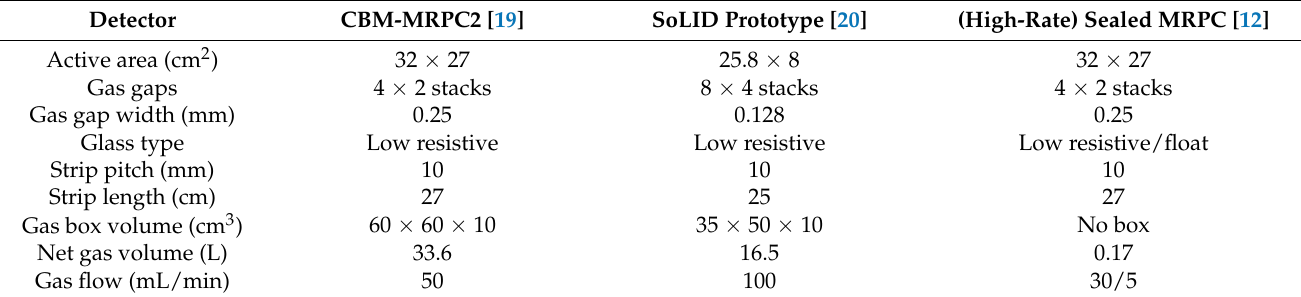
Figure 3. The current response of a SoLID prototype in full X-ray irradiation, in an estimated counting rate of 1 kHz/cm 2 . Table 1. The geometry parameters of the MRPC prototypes discussed in the paper.